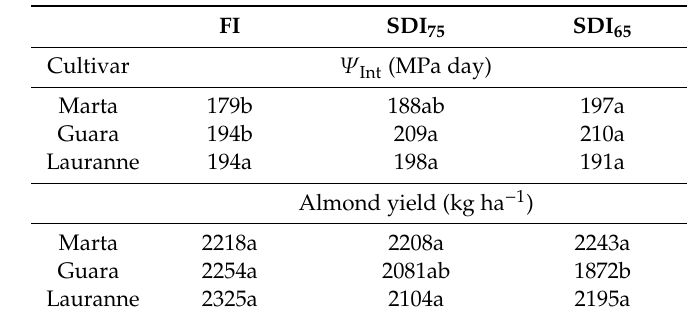
Table 2. Integral stress ( Ψ Int ) values and almond yield for the di ff erent cultivars and irrigation